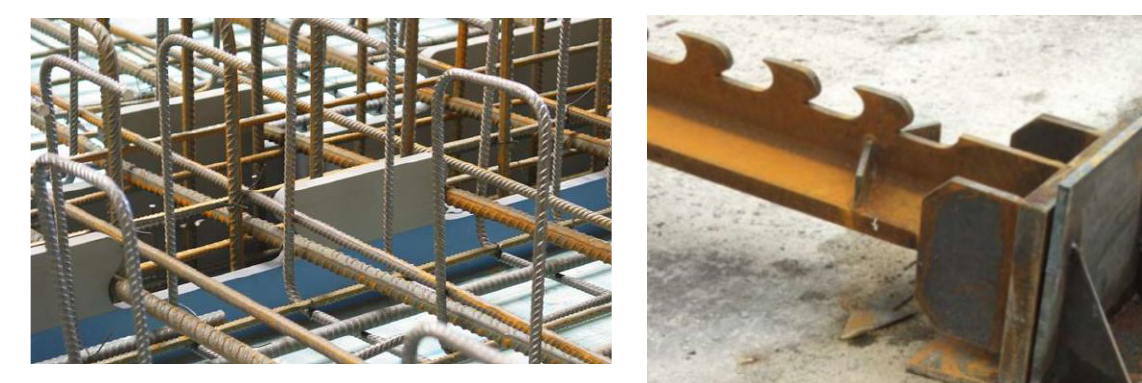
Figure 5: Shear connection for the viaduct in Pöcking [50] with puzzle-shaped dowels.